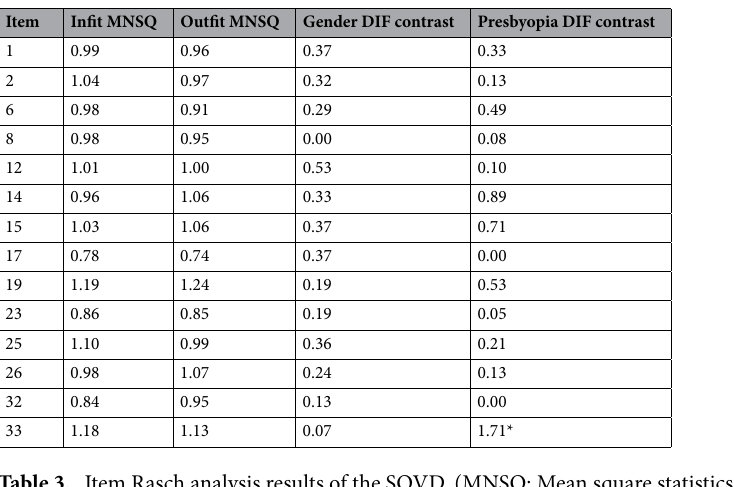
Table 3. Item Rasch analysis results of the SQVD. (MNSQ: Mean square statistics; DIF: Differential item functioning). * p < 0.05.